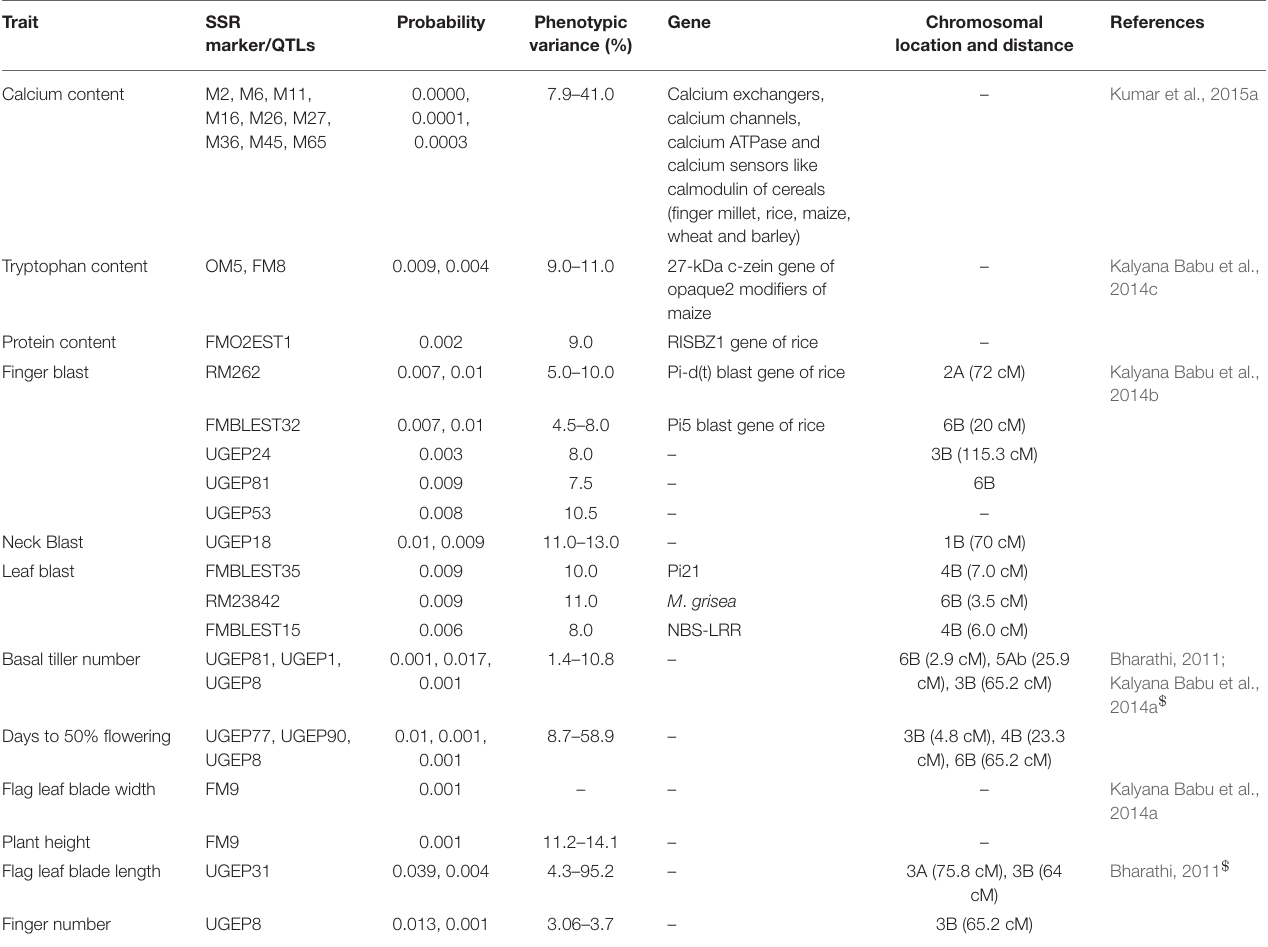
TABLE 2 | Association mapping studies for identification of linked markers in finger millet.